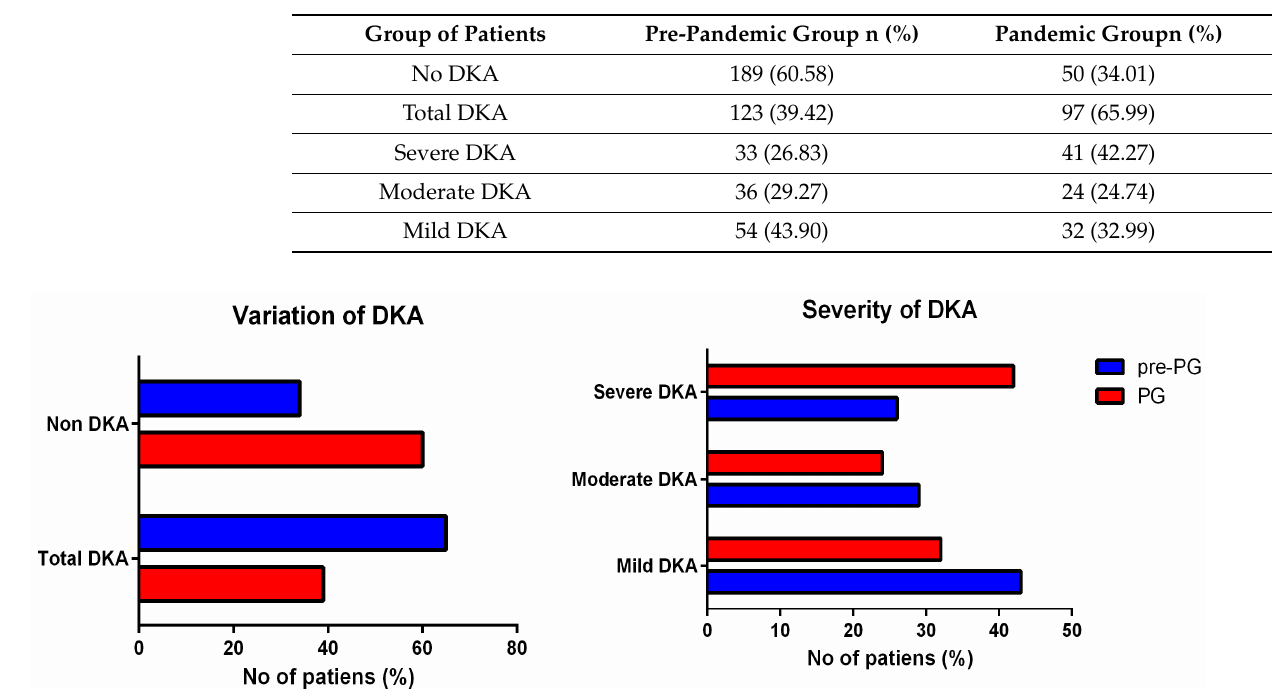
Figure 3. DKA presence and severity in the pre-pandemic group of patients (pre-PG) and the pandemic group (PG).